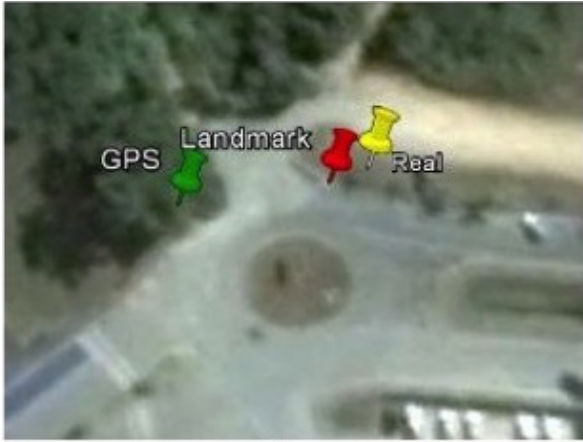
Figure 5. Auto-localization position comparison between GPS, Landmark Recognition Estimation, Real UAV Position in the roundabout landmark.